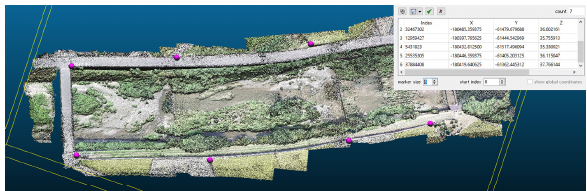
Figure 7. Validation point of point cloud data